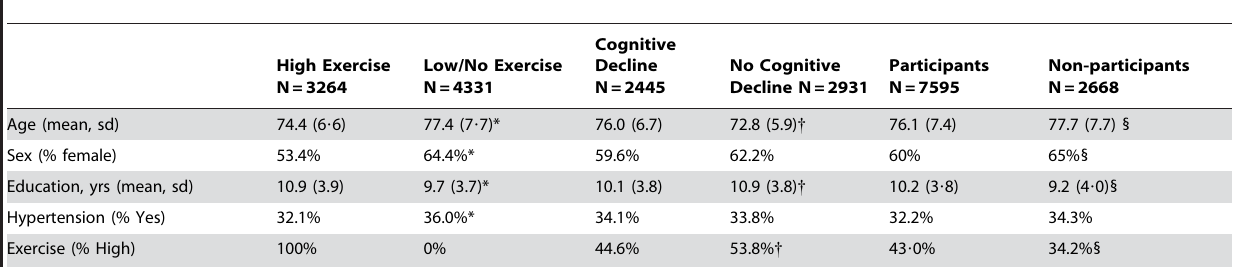
Table 1. Descriptive traits of high versus low/no exercise groups and respondents versus